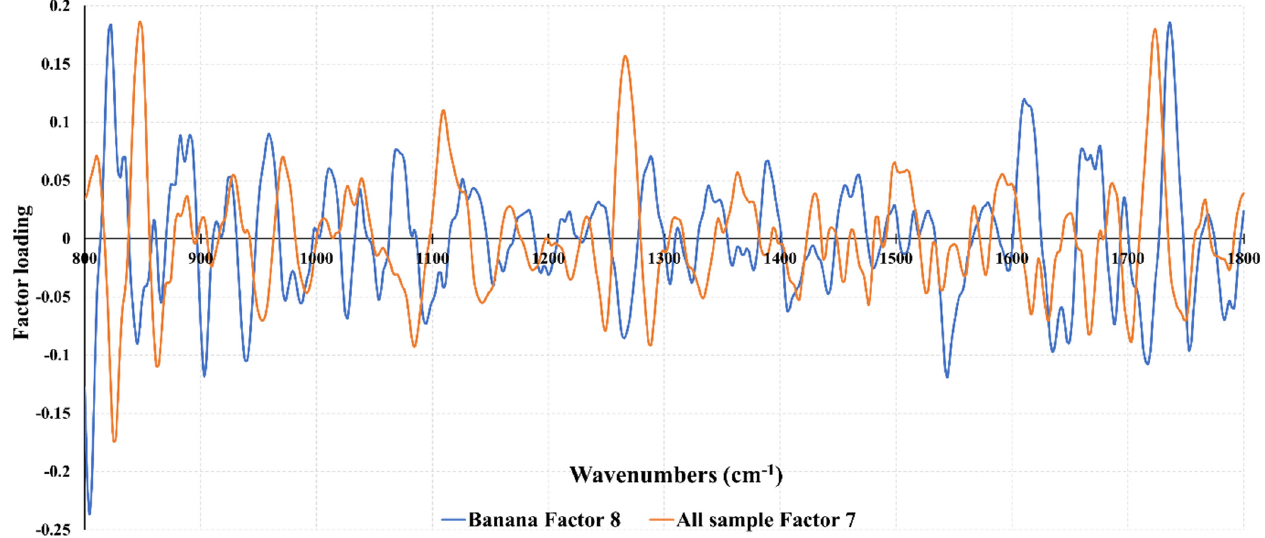
Figure 2. Partial least squares loadings derived from the calibration models used to predict satiety in the saliva of all samples or in the banana samples.